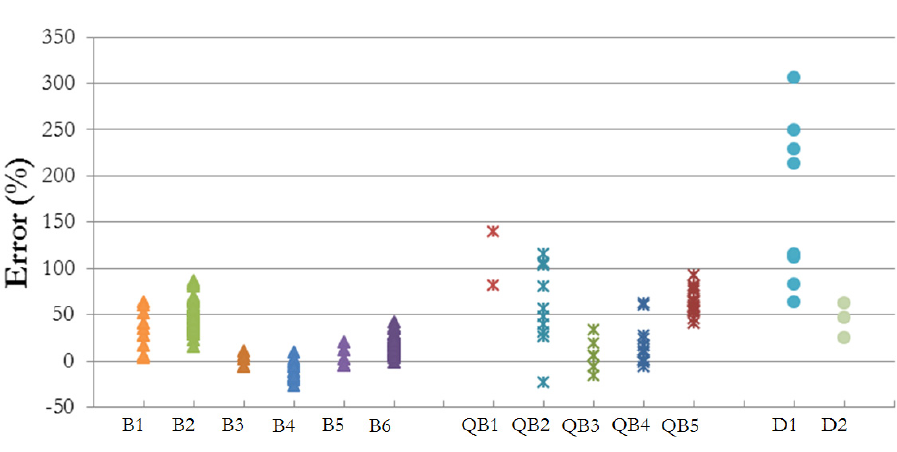
Figure 3: Error results using 1 st Principal Stress as effective stress.